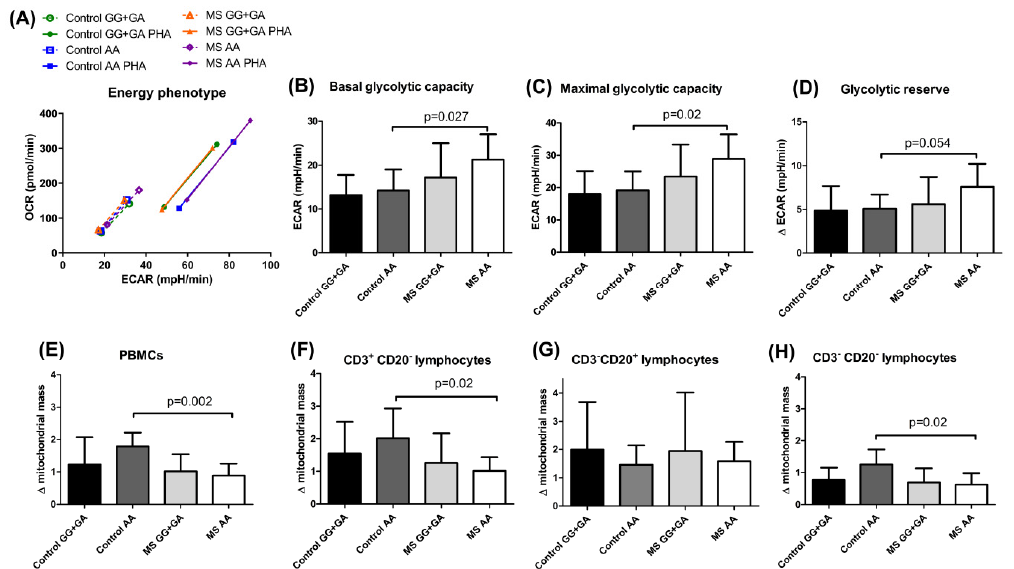
Figure 3. Glycolytic profile and mitochondrial mass of PBMCs from multiple sclerosis (MS) patients and controls stratified by the genotypes of HHEX rs7923837. ( A ) Energy phenotype of the studied groups. Minimum and maximum values of extracellular acidification rate (ECAR) and oxygen consumption rate (OCR) were confronted to obtain an estimation of the metabolic range of the cells. ( B – D ) Glycolytic analysis comparing carriers of the major allele in HHEX rs7923837 and minor-allele homozygotes from both MS patients and controls. Control GG + GA: n = 11; Control AA: n = 7; MS GG + GA: n = 18; MS AA: n = 7. ( E – H ) Increase in mitochondrial mass measured by flow cytometry with Mitotracker Green TM after activation with PHA. The ratio of the median fluorescence intensity in the presence/absence of PHA was calculated for PBMCs ( E ) and the indicated lymphocyte subpopulations ( F – H ). Control GG + GA: n = 9; Control AA: n = 5; MS GG + GA: n = 17; MS AA: n = 8. Mean and standard deviation are presented in panels ( B – H ).